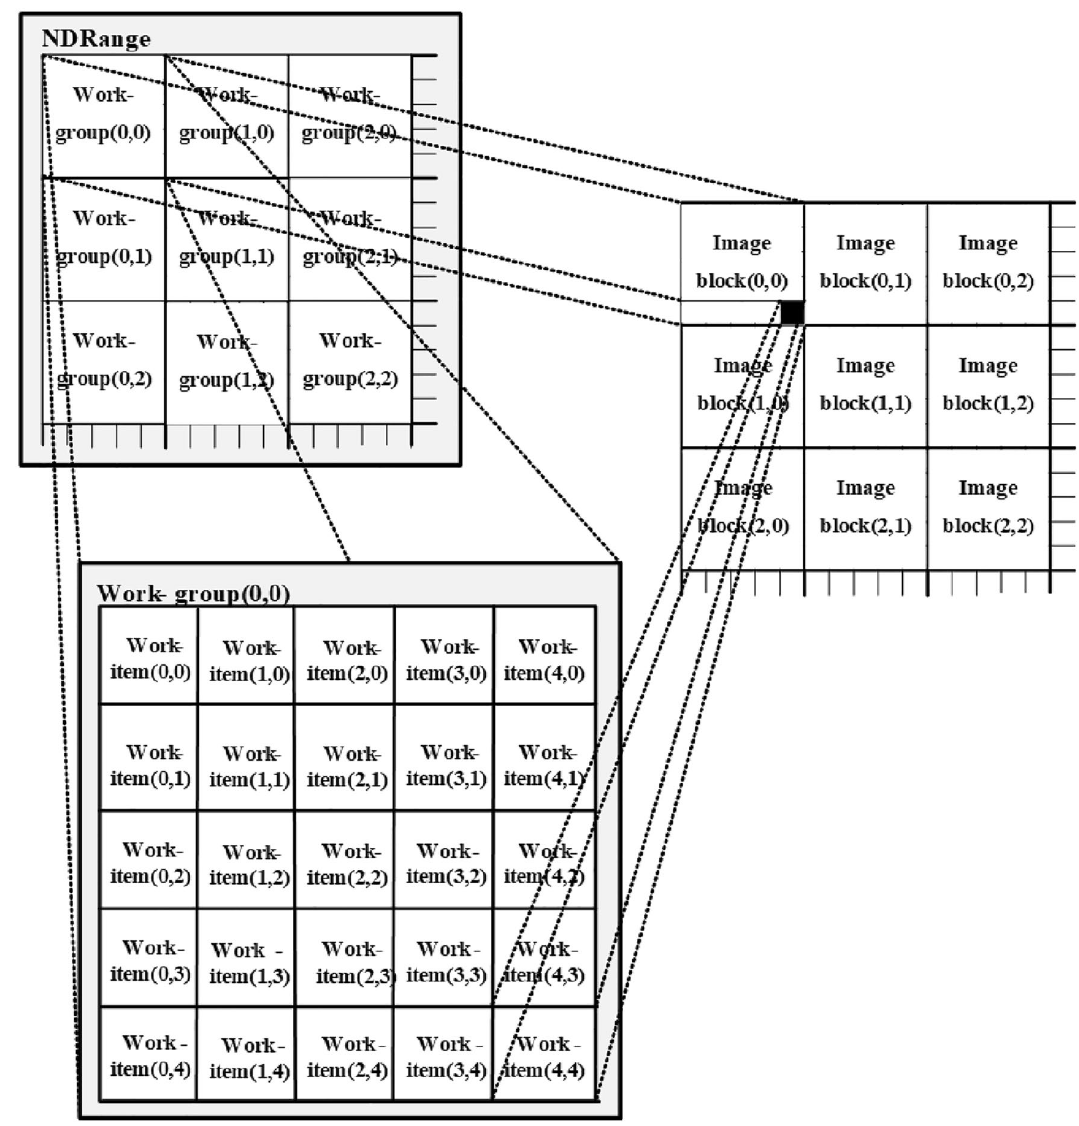
Figure 4. Correspondence relationship diagram between work-items and